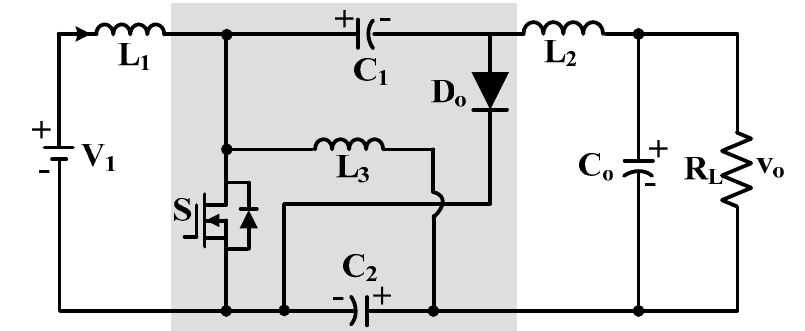
Figure 1. Topology of proposed novel Ć uk converter.